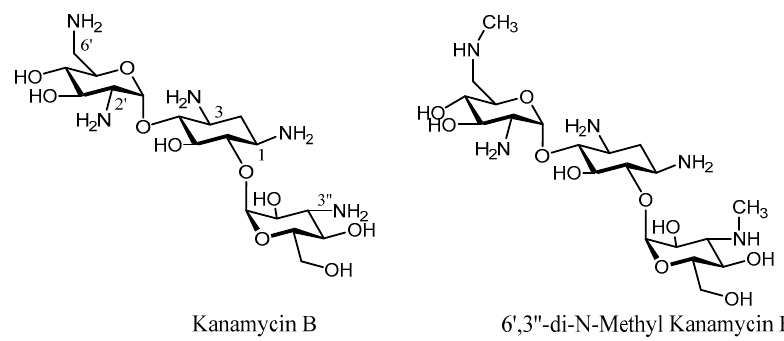
Figure 2. Structures of Kanamycin B and 6’,3’’-di-N-Methyl Kanamycin B.